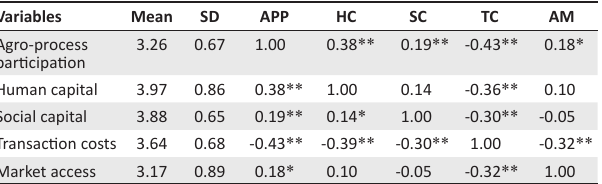
TABLE 2: Descriptives and correlation matrix. Variables